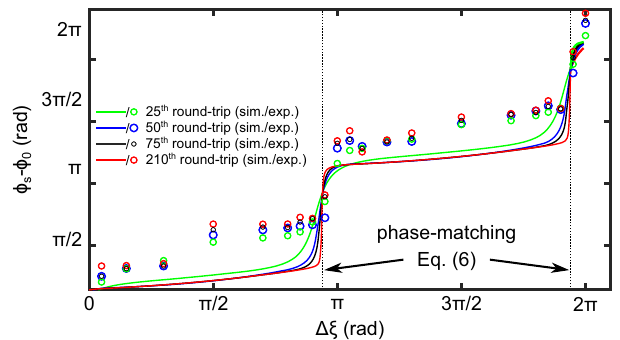
Fig. 6 Output phase evolution. Relative phase between the signal and the pump versus Δ ξ (relative input phase) at n = 25, 50, 75, and 210 cavity round-trips. Solid curves stand for numerical simulations from the Lugiato − Lefever equation (Eq. 4) and circles for experimental measurements. Vertical black dotted lines correspond to Eq. 1. Sim : simulations, Exp : experiments, and ϕ s − ϕ 0 (pump-signal signal phase